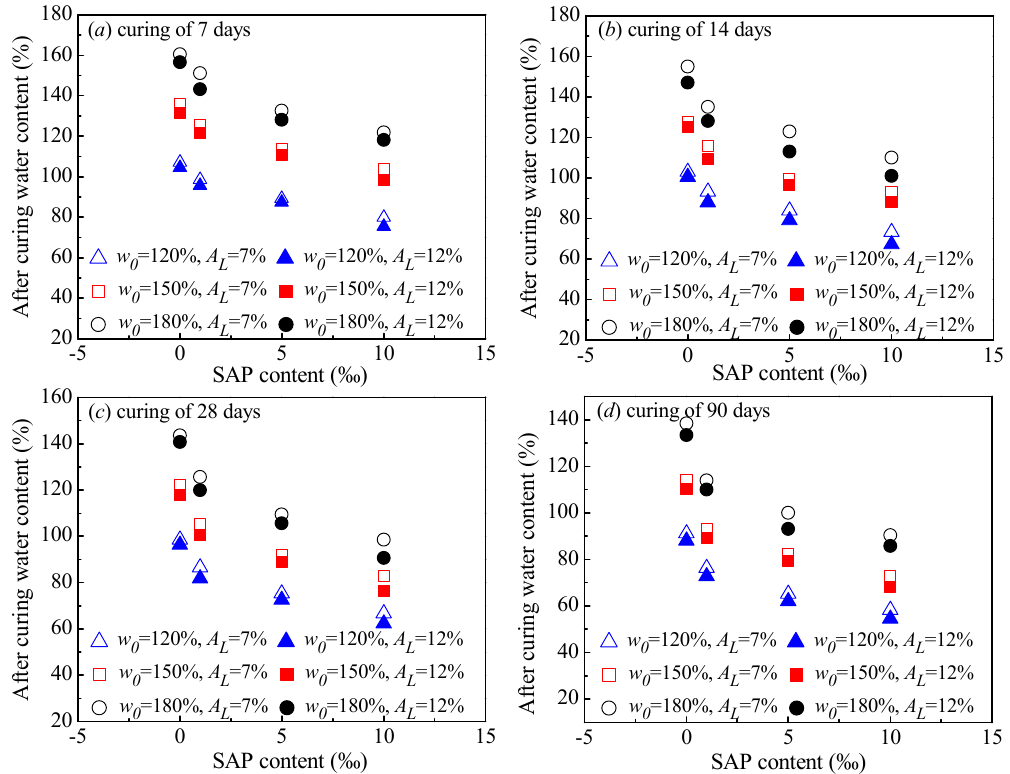
Figure 6. Variation of after curing water content with SAP content.